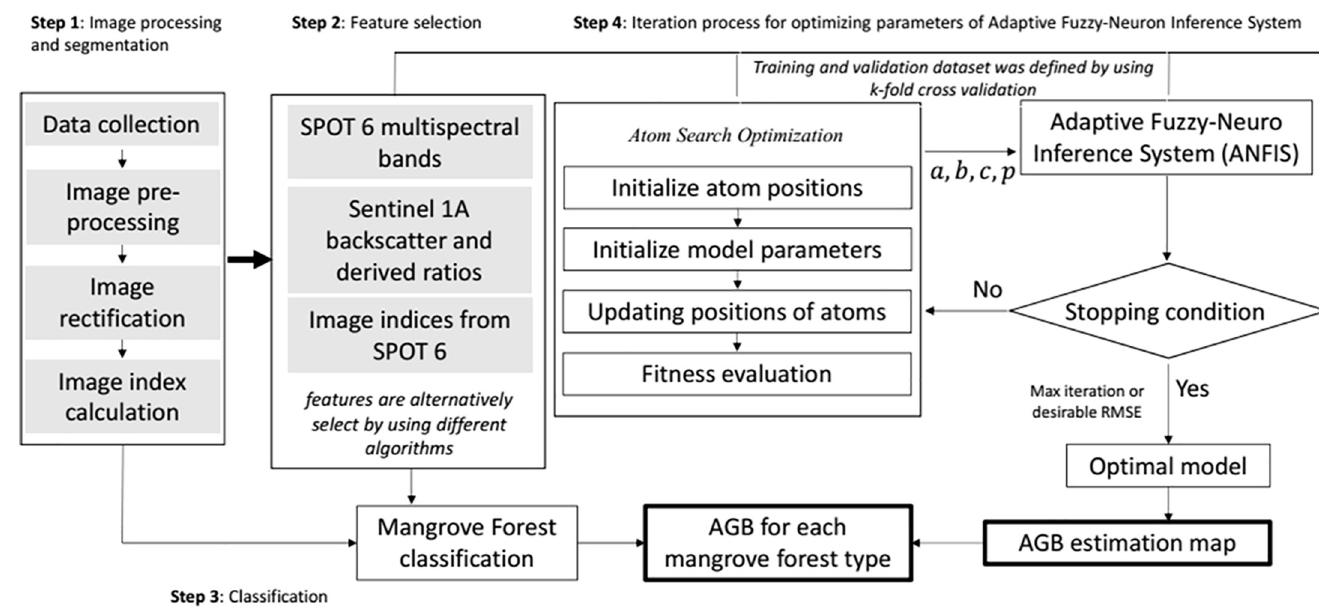
Fig 3. AGB estimation